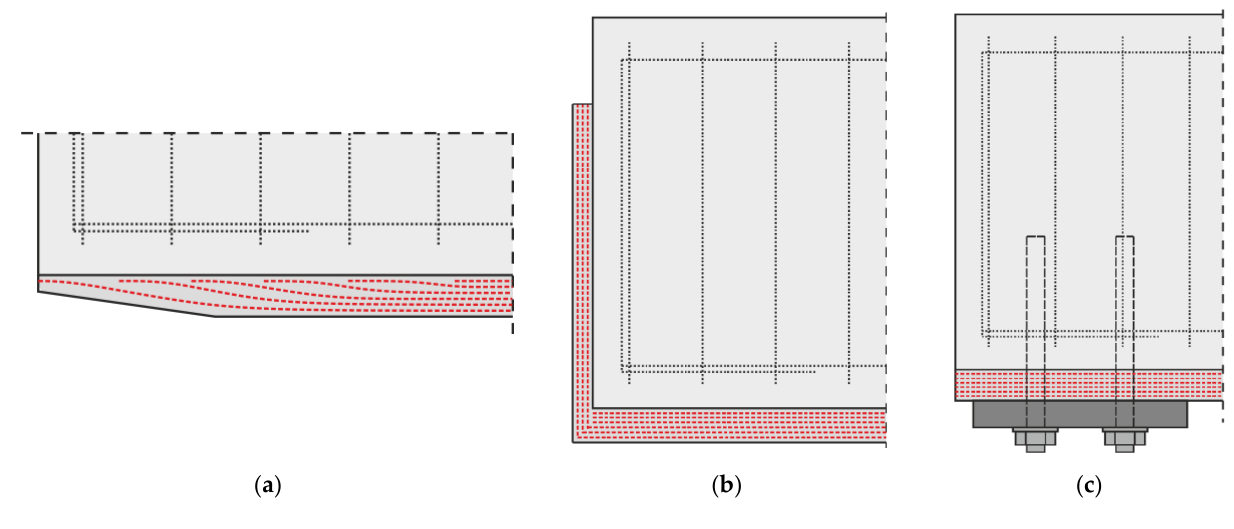
Figure 14. Possible solutions to avoid concrete cover separation: ( a ) staggered carbon reinforcement; ( b ) leading carbon reinforcement upwards behind the support; ( c ) doweling. (Graphic: CARBOCON GMBH).